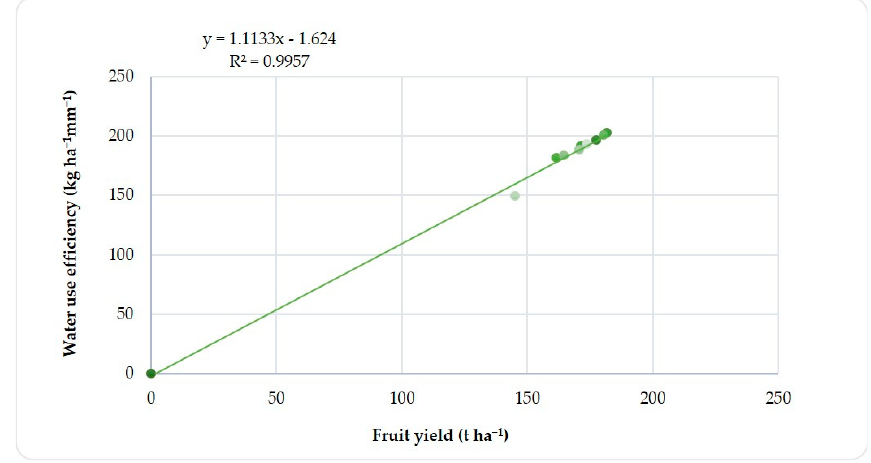
Figure 1. Relationship between fruit yield and water use efficiency of tomato during 2020–2021 and 2021–2022.